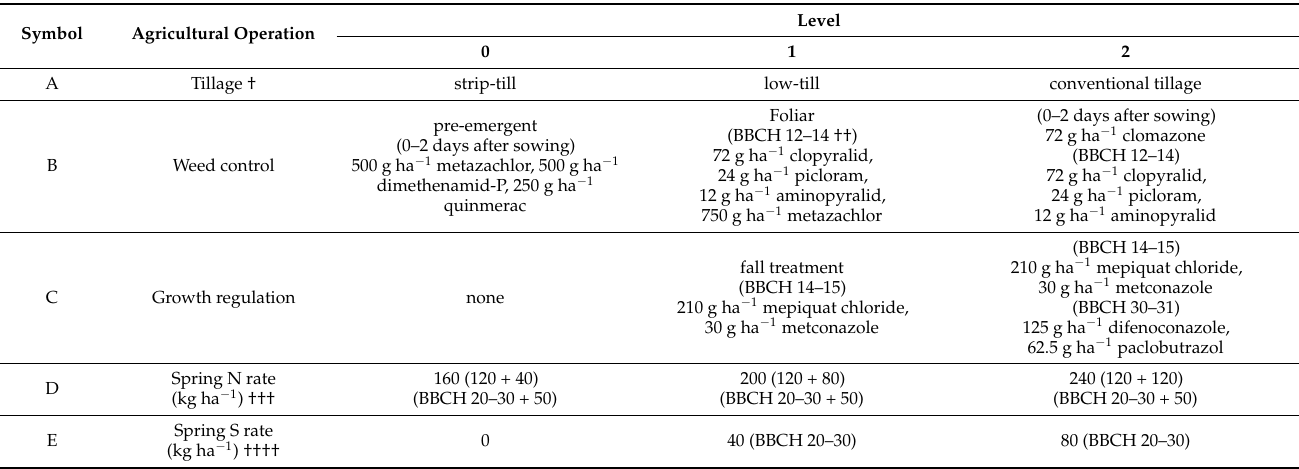
Table 1. Experimental